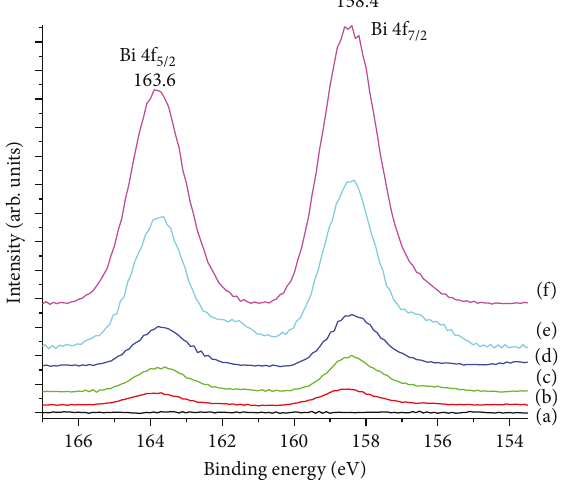
Figure 6: XPS spectra evolution of Bi 4f region as a function of bismuth content, (a) 0, (b) 0.5, (c) 4.9, (d) 10.4, (e) 21.5, and (f) 25.4at.